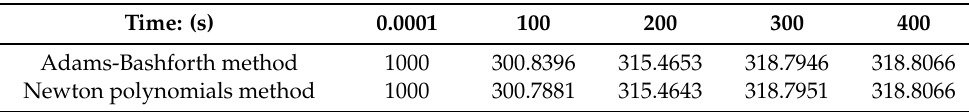
Table 1. Results of the two numerical schemes for the susceptible CD4 + T-cells T (s) under the fractal order and fractional order δ = σ = 0.95 with the step size h = 0.1. Time: